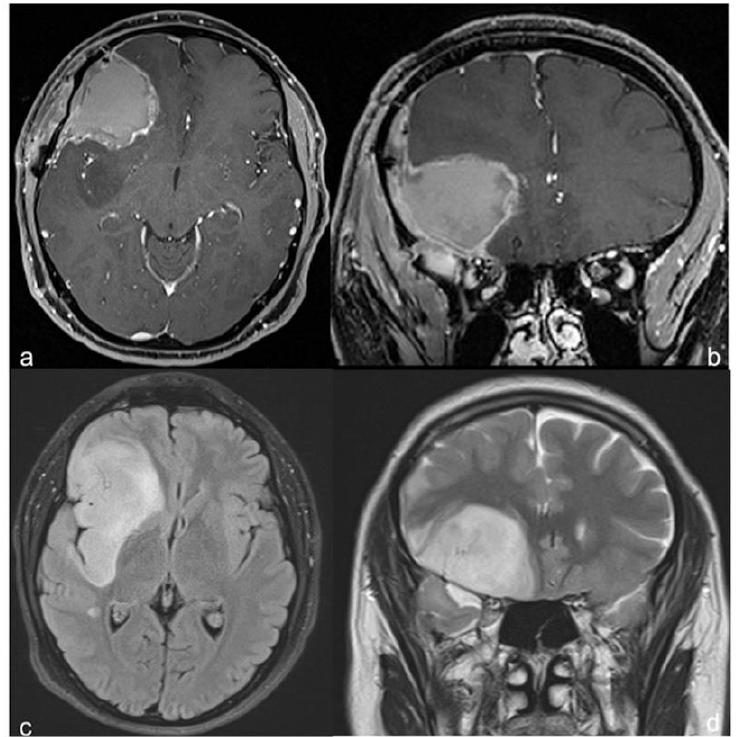
Figure 4. Postoperative brain MRI . Axial ( a ) and coronal ( b ) postcontrast T1-weighted, and axial ( c ) and coronal ( d ) T2-weighted, sequences; large resection of the frontal supra-sylvian tumor com- ponent.